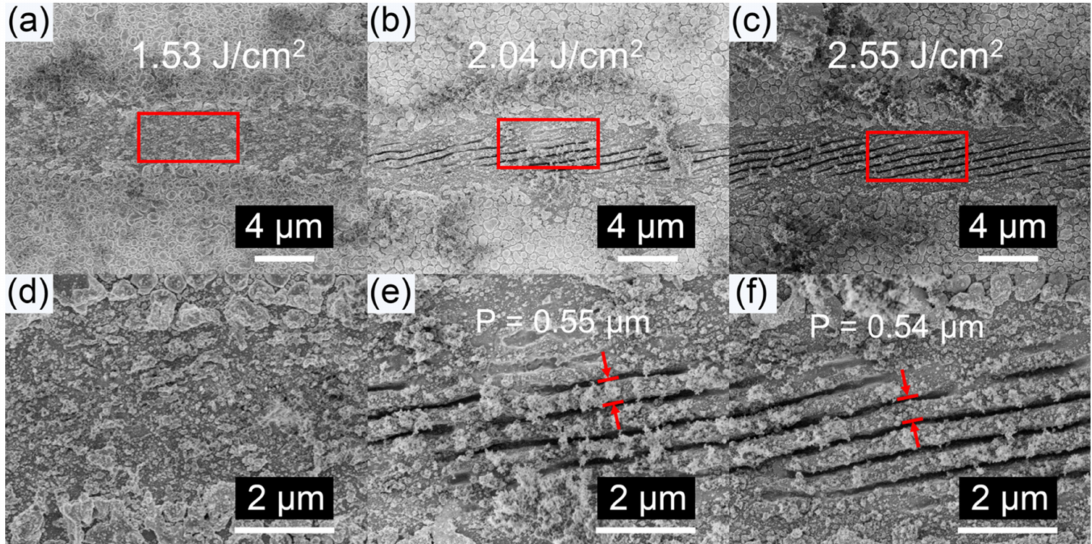
Figure 5. SEM images of the surface morphologies with a scan speed of 20 µ m/s on BiIn-Si. ( d – f ) are the magnified versions of the areas within the red rectangles of ( a – c ), respectively. P is the period of the ripples.